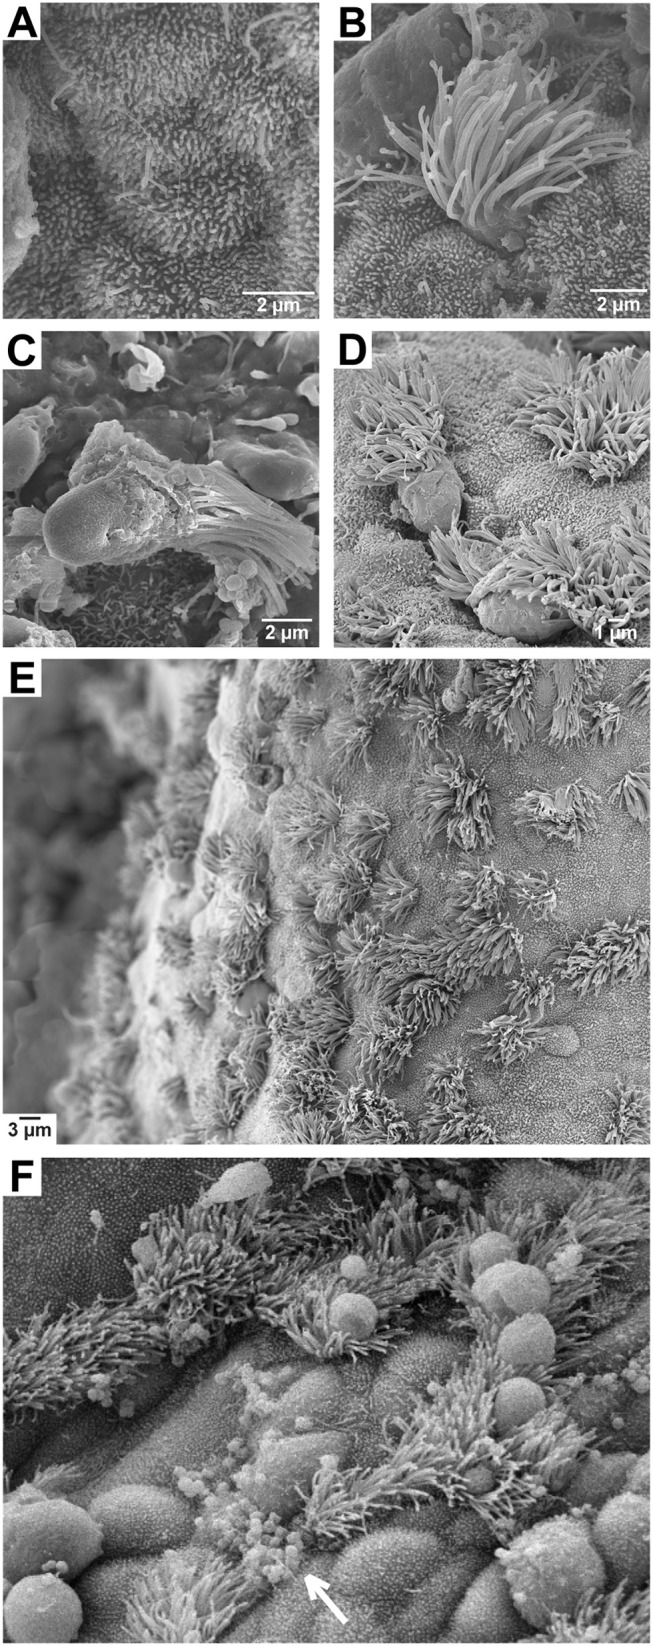
Scanning electron micrographs of fallopian tube explants. (A) Non-ciliated (secretory) epithelial cell; (B) ciliated epithelial cell; (C) ciliated epithelial cell sloughed during gonococcal infection; (D) ciliated cells sloughing following a 24 h treatment with 2 ng/mL TNFα; (E) an untreated epithelial layer displaying normal cell morphology; (F) an epithelial layer during gonococcal infection showing binding of most bacteria to non-ciliated cell surfaces (arrow) and swelling of cells that precedes ciliated cell sloughing.